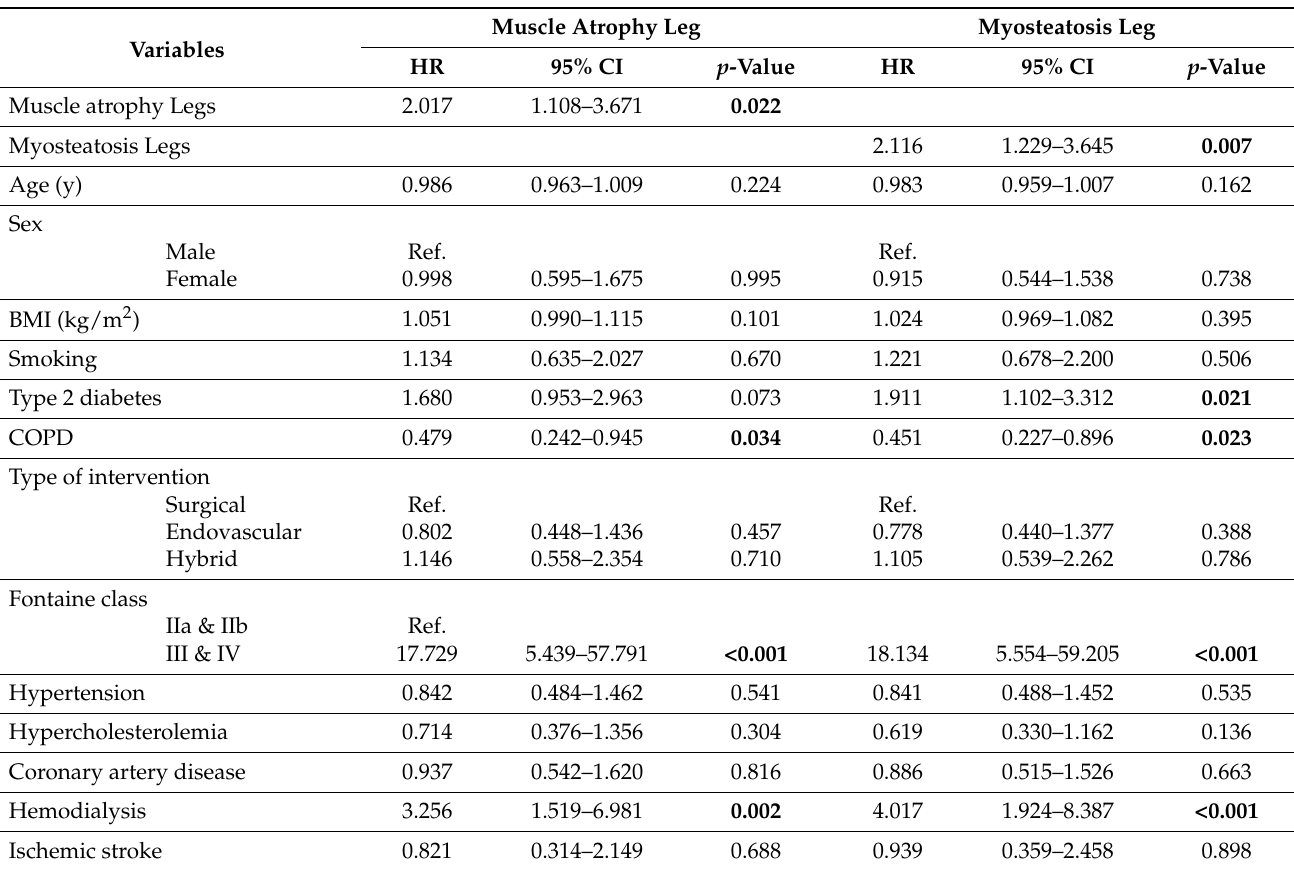
Table 6. Multivariable Cox proportional hazards model for muscle atrophy and myosteatosis for amputation-free survival in PAD